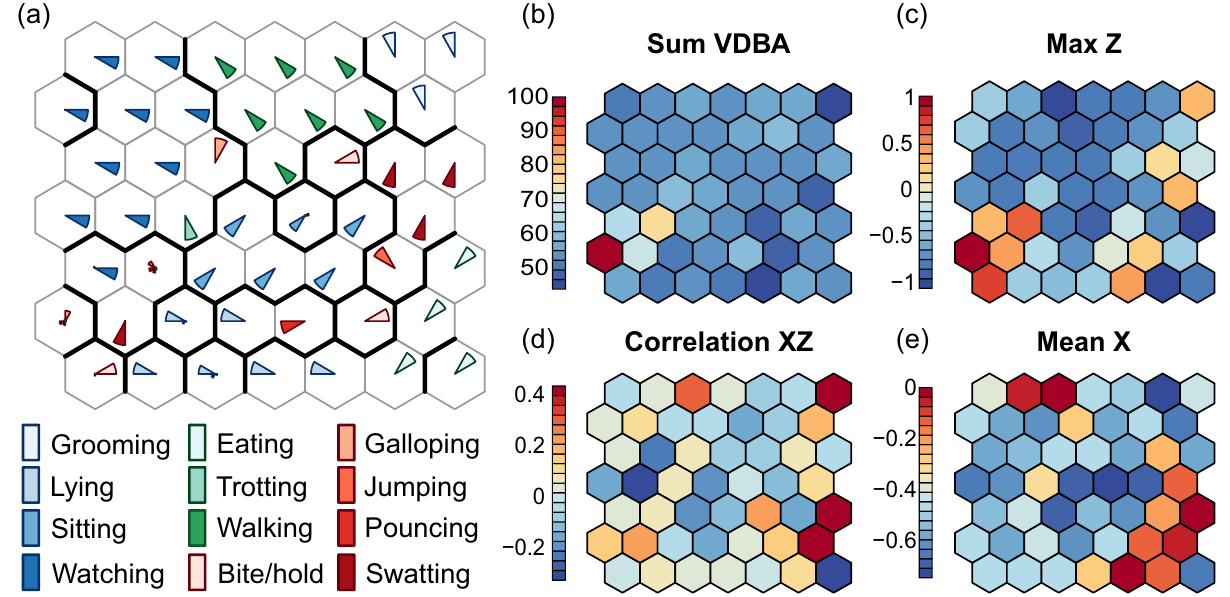
Figure 3. ( a ) The self-organising map comprising 49 hexagonal cells, each identifying a unique accelerometer signature. The thick black lines separate and cluster the identified behaviours in which the procedure believes are most similar. A single triangle represents a behaviour identified 100% of the time. The colour of each triangle indicates which activity is represented in the cell, and proximity of cells to each other indicates the similarity of their signature. ( b – e ) Component planes for four example classifiers with heat maps indicating the relative importance of classifiers among different